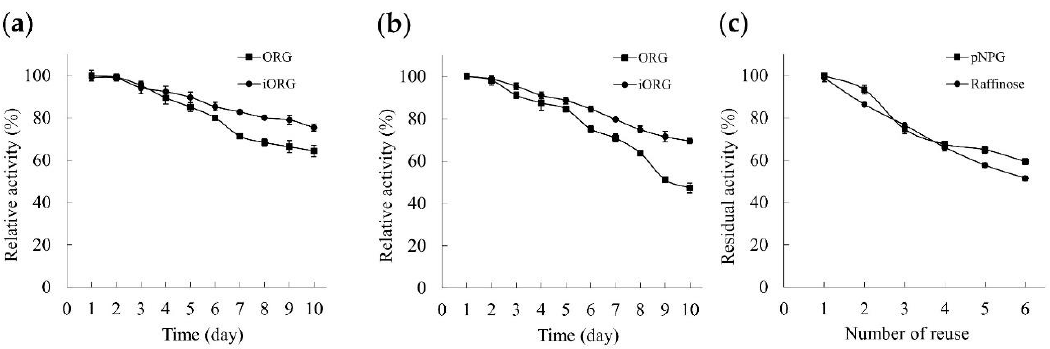
Figure 8. Storage stability of ORG and iORG at 4 °C ( a ) and room temperature ( b ); reusability of iORG ( c ).